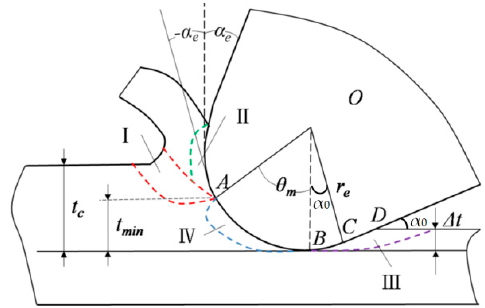
Figure 1. Micro machined surface formation process.